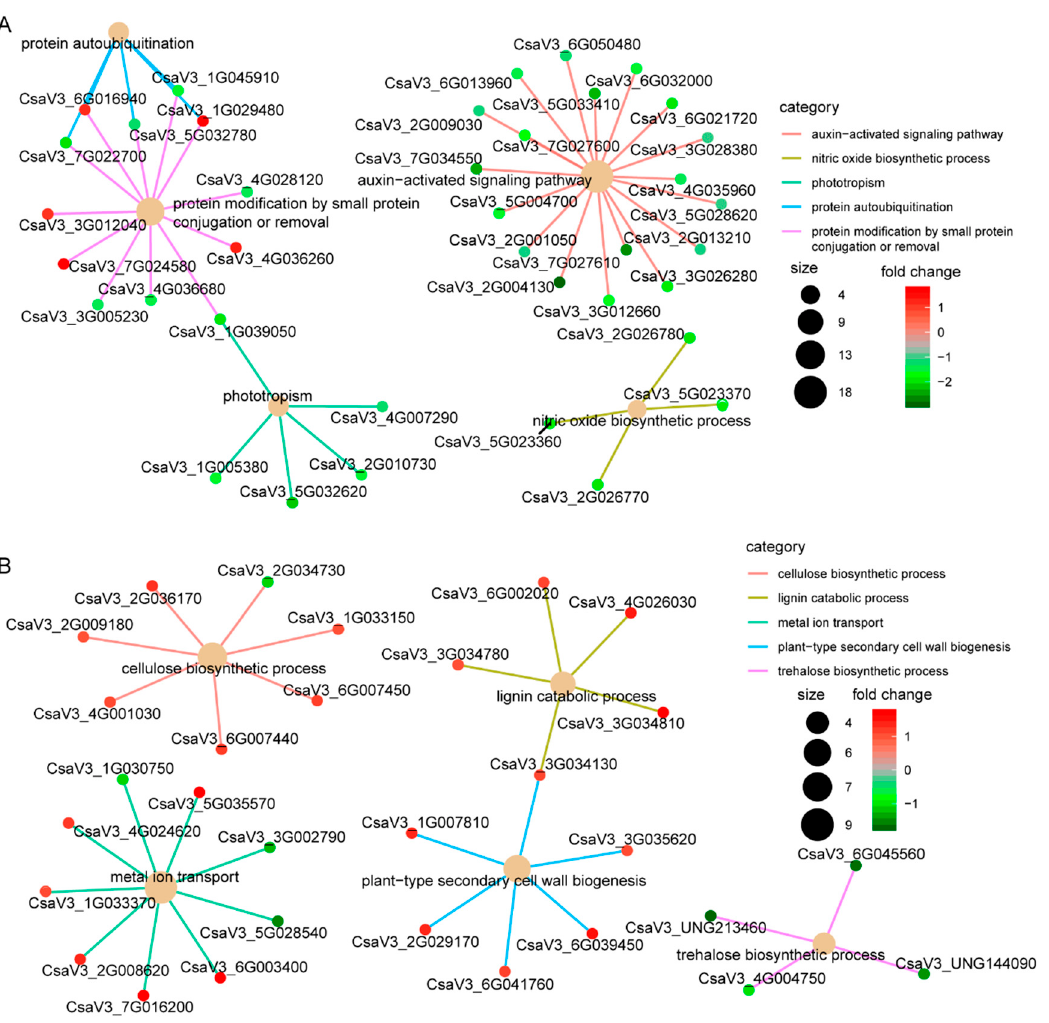
Figure 6. Cnetplot diagram showing the most significantly enriched 5 items in GO analysis (a bio- logical process). ( A ) Comparing a pair of CT57S vs. CT90R in leaves. ( B ) Comparing a pair of CT57S vs. CT90R in roots.